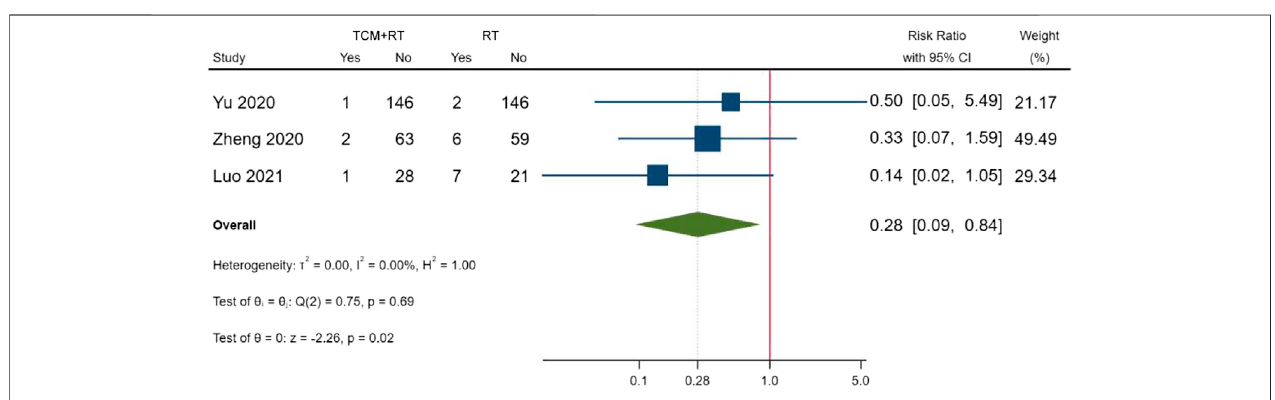
FIGURE 9 | Forest plot of